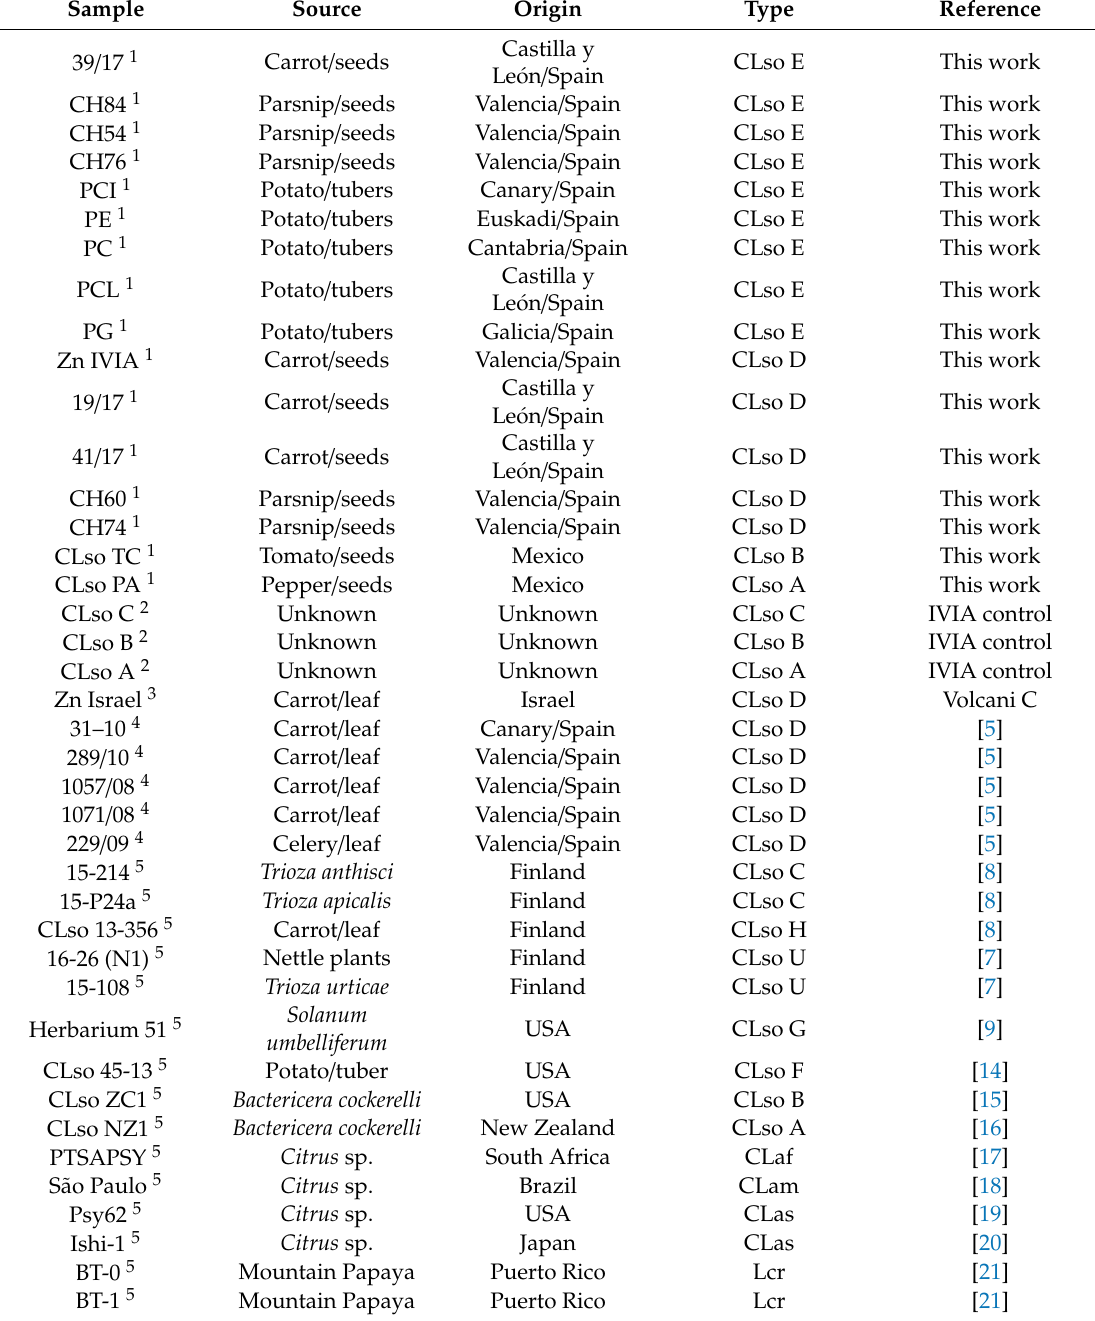
Table 1. Liberibacter Isolates